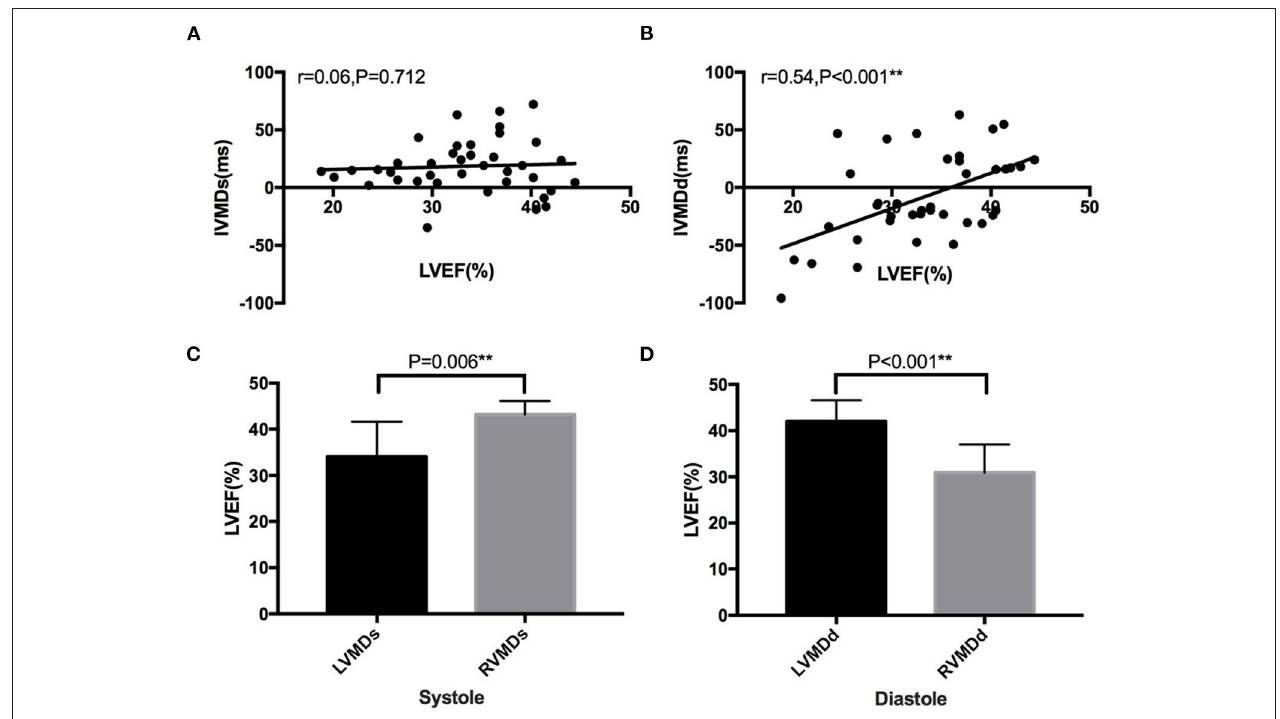
FIGURE 5 | Correlation between IVMD and LVEF in patients with heart failure. No significant correlation between (A) IVMDs and LVEF ( r = 0.06, p = 0.712), but a positive correlation between (B) IVMDd and LVEF ( r = 0.54, p < 0.001). Significant differences in LVEF between HF patients with different ventricular mechanical sequences (C,D) . LVMDs, left ventricular mechanical delay in systole; LVMDd, left ventricular mechanical delay in diastole; RVMDs, right ventricular mechanical delay in systole; RVMDd, right ventricular mechanical delay in diastole; IVMD, interventricular mechanical delay; IVMDs, systolic interventricular mechanical delay; IVMDd, diastolic interventricular mechanical delay; LVEF, left ventricular ejection fraction. **denotes results satisfying the significance criterion p <